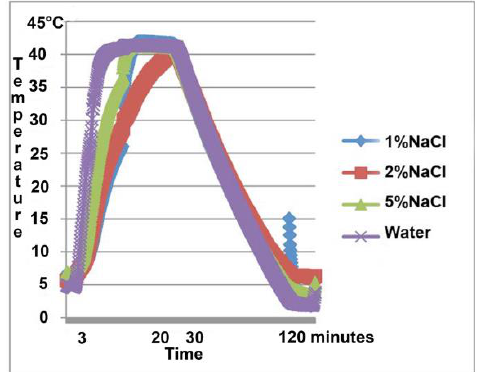
Figure 4 . Heating – cooling curves for different mixtures of NaCl and Na 2 SO 4 in water with CMC added as stabilizing gelifier. The PCM mixtures are compared to water, also gelified by CMC (purple). During heating, all three PCM mixtures differ from water by having a lesser slope and also by brief periods of energy take up at around 30 – 32 °C (1% NaCl, blue curve is partly hidden). During cooling, there is less diversity, although the slopes of the PCM curves are less steep than that of water. Please note that lowering the bath temperature to 5 °C caused a temporary increase of temperature in PCM containing 1% NaCl (blue).